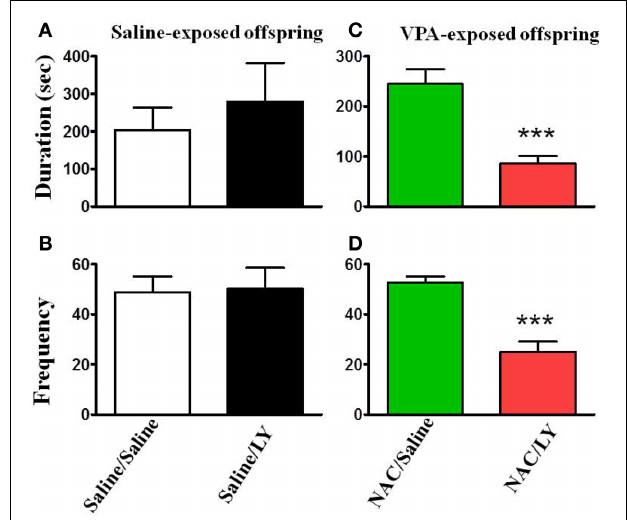
FIGURE 6 | NAC-mediated reversal of social interaction deficit in VPA-exposed offspring is blocked by mGluR2/3 antagonist. (A,B) Rats of saline-exposed offspring weaned at postnatal day 21. At postnatal day 24, the rats received an intra-amygdala injection of LY341495 (2 µ g/0.5 µ l per side) or saline once per day for 5 days. One hour after the last injection of LY341495 or saline, the rats were administered the social interaction test. The duration (A) and frequency (B) of contact between the VPA- and saline-exposed offspring were measured for 20min. Sample sizes ( n ): Saline/Saline n = 4, Saline/LY n = 5. (C,D) Rats of VPA-exposed offspring weaned at postnatal day 21 were administered an intraperitoneal injection of NAC (150mg/kg) once per day for 8 days. At postnatal day 24, the rats received an intra-amygdala injection of LY341495 (2 µ g/0.5 µ l per side) or saline 30min before NAC once per day for 5 days. One hour after the last injection of LY341495 or saline, the rats were administered the social interaction test. The duration (A) and frequency (B) of contact between the VPA- and saline-exposed offspring were measured for 20min. Sample sizes ( n ): Saline/Saline n = 9, Saline/LY n = 9. ∗∗∗ p < 0 . 001 vs.